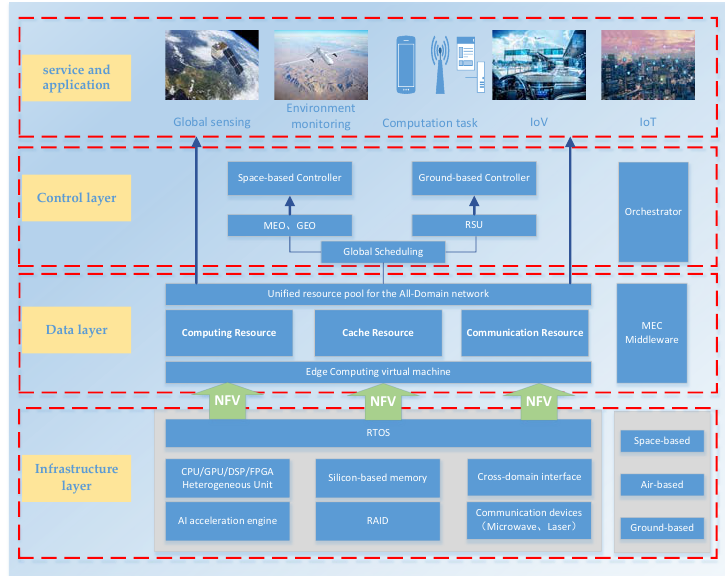
Figure 2. SAGIN resource service framework.